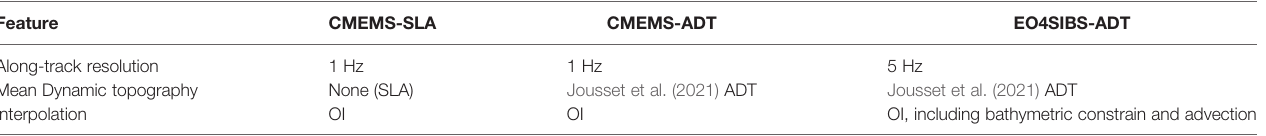
TABLE 1 | Main processing differences between the four altimetric data